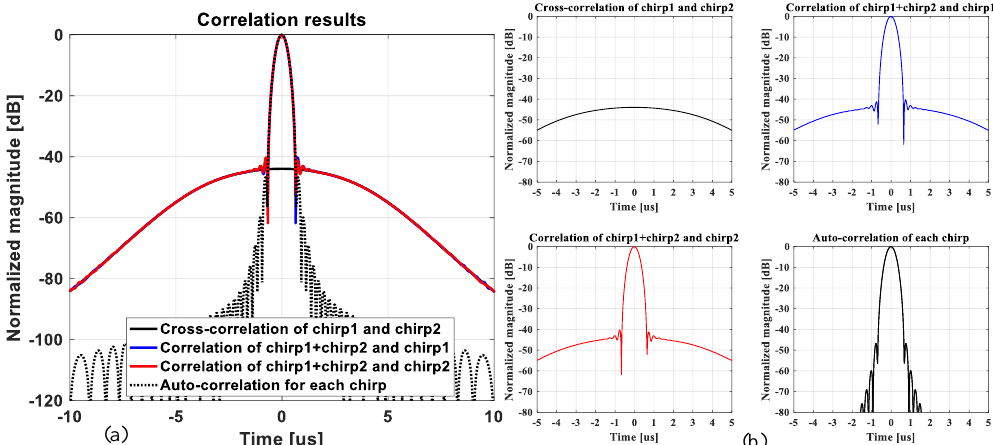
Figure 5. ( a ) Correlation results in time to show the cross-correlation of the two chirps (black solid line), the correlation of combined two chirps and chirp1 (blue solid line), the correlation of combined two chirps and chirp2 (red solid line) and the auto-correlation of each chirp (black dotted line) and ( b ) those zoomed-in and separate plots.